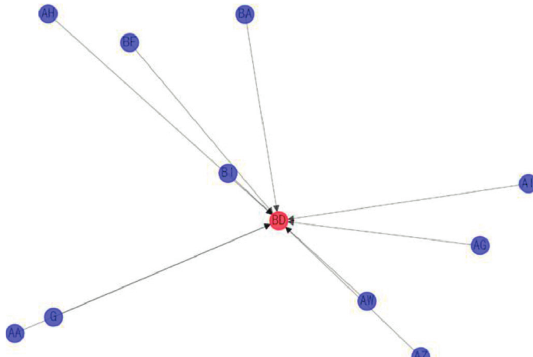
Figure 9: The causal graph of the local process of MMHC flight